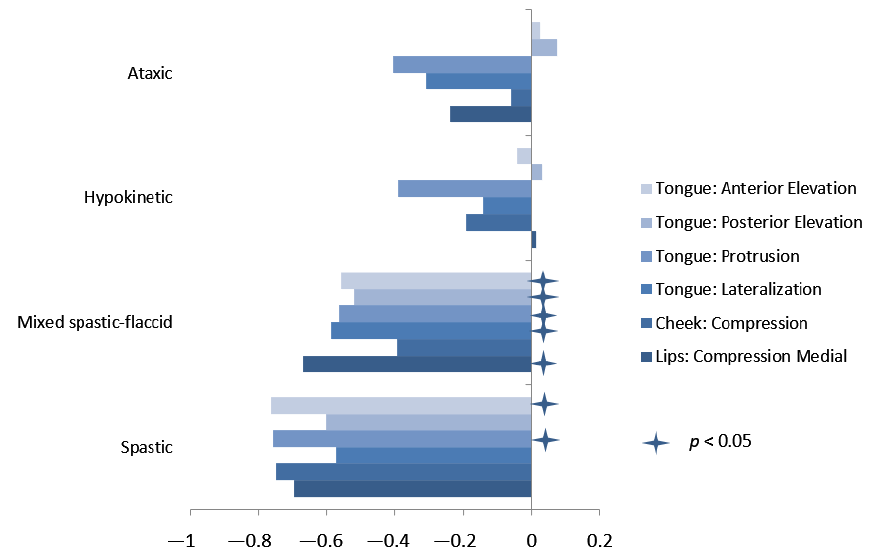
Figure 3. Correlations between strength measures and dysarthria severity by group.